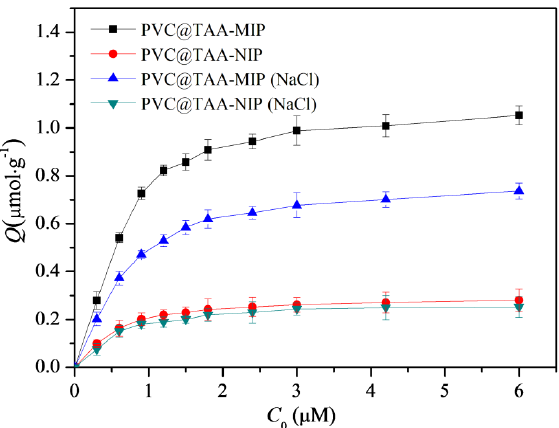
Figure 7. Binding isotherms of PVC@TAA − MIP and PVC@TAA − NIP toward BSA in absence or presence of NaCl.